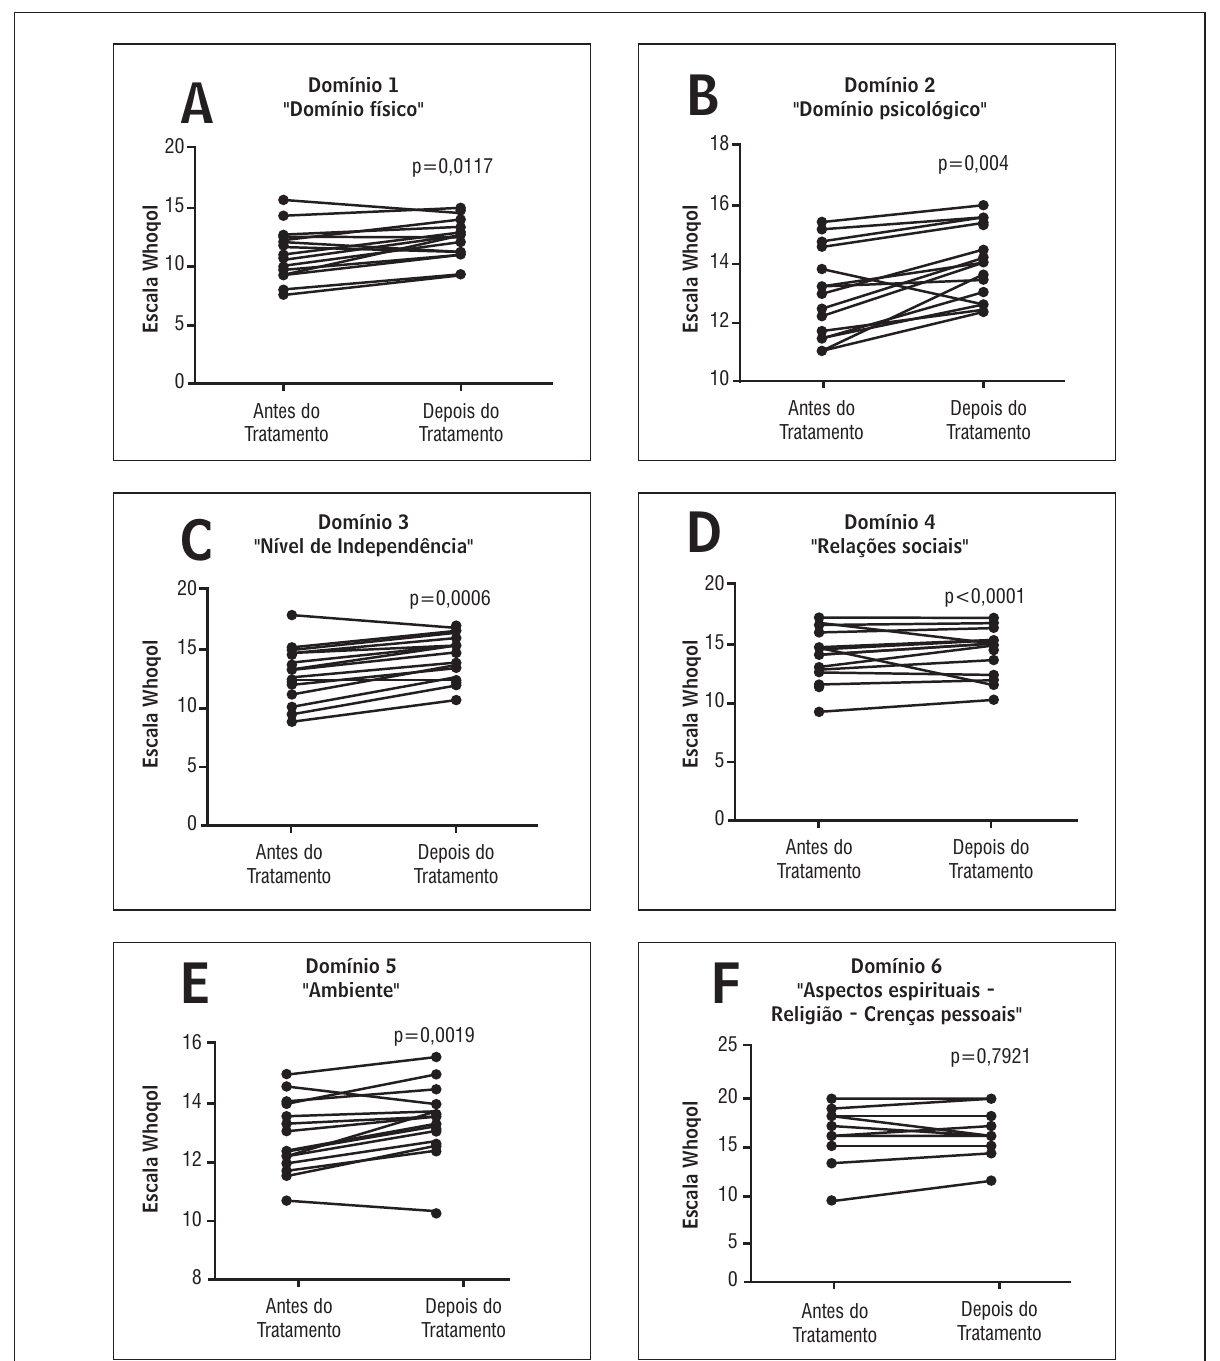
Figura 1 – Valores dos domínios antes e após o tratamento fisioterapêutico Fonte: Dados da